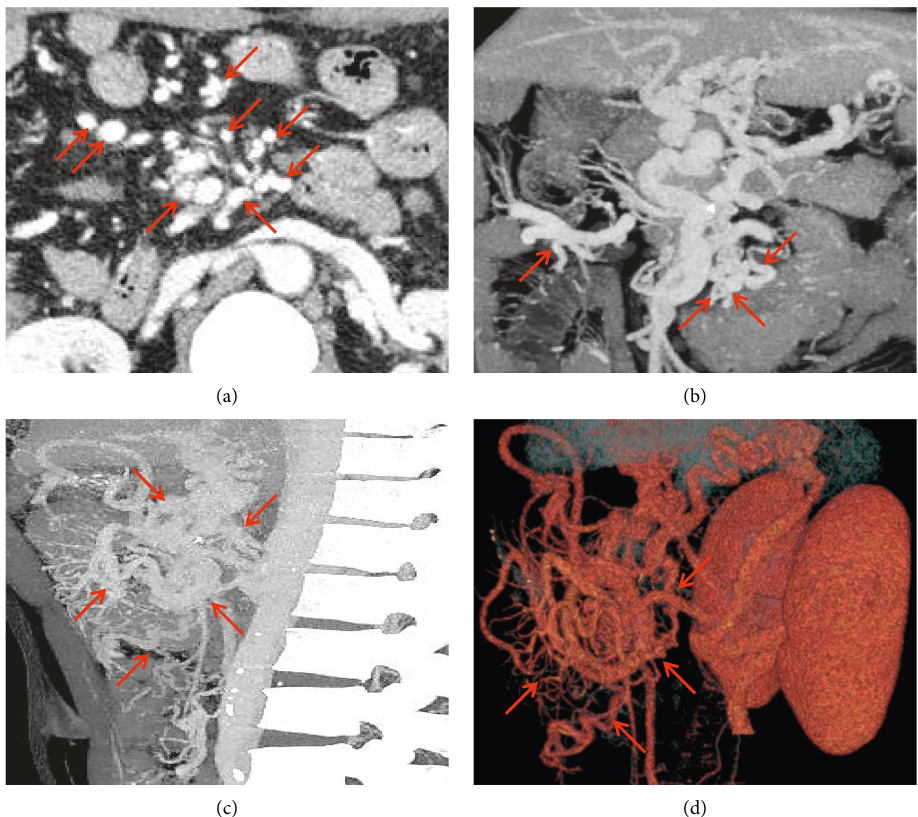
Figure 11: Retzius vein. A 48-year-old male patient with an eleven-year history of alcoholic-related liver cirrhosis presented with hematochezia. The contrast-enhanced CT scan on the portal vein phase demonstrated that the Retzius vein (red arrow) manifested as tortuously dilated vessels in the retroperitoneum in the portal vein phase. (a) Axial contrast-enhanced CT; (b) coronal contrast-enhanced CT; (c) sagittal contrast-enhanced CT; (d) three-dimensional